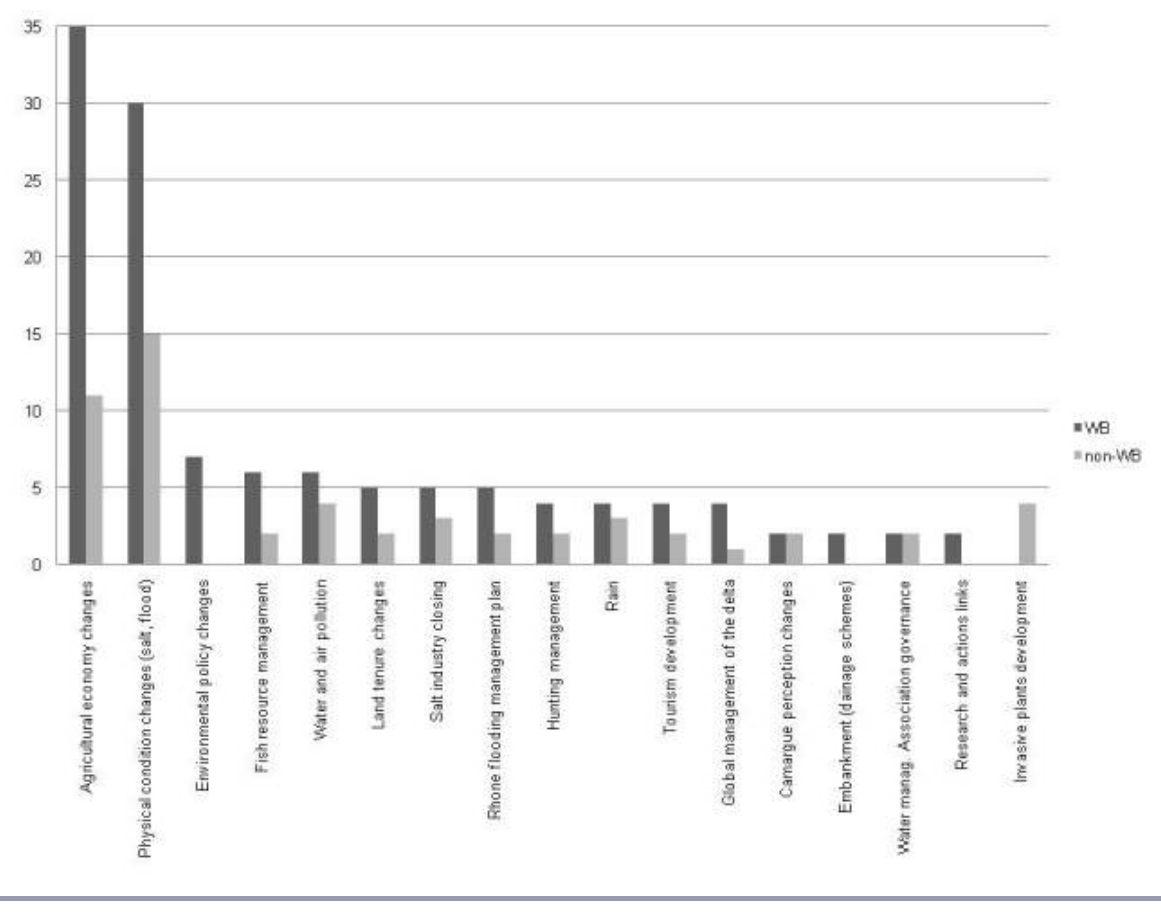
Fig. 4 . Frequency with which members (WB) and nonmembers (non–WB) of the Water Board listed each of the main